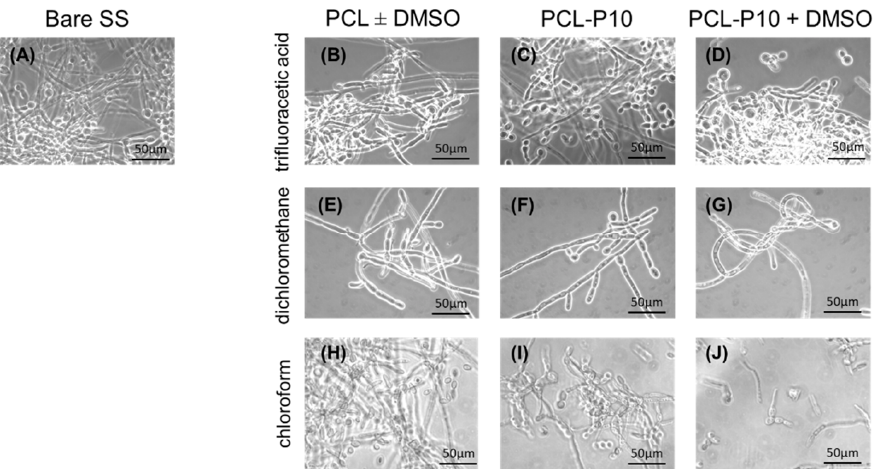
Figure 3. Analysis of planktonic C. albicans cells in the presence of different PCL coating formulations; representative optimal images of the planktonic cells observed by optical microscopy, with a magnification of 1000×, when in the presence of bare stainless steel (control, ( A ); PCL formulations using trifluoroacetic acid ( B ), dichloromethane ( E ) or chloroform ( H ), without or with DMSO; coatings only with PCL ( B , E , H ) or with embedded compound P (PCL-P10) without DMSO ( C , F , I ) or with DMSO ( D , G , J ).